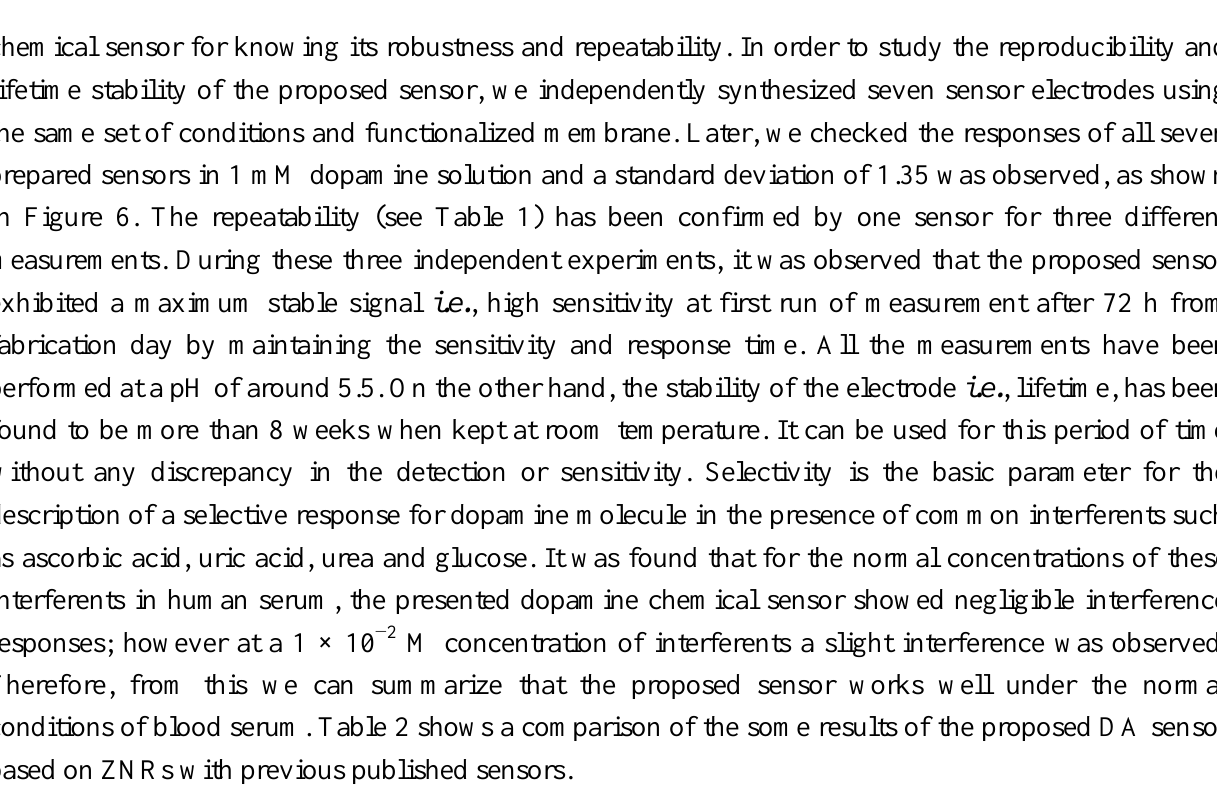
Figure 6. Reproducibility measured in 1 mM concentration of dopamine.